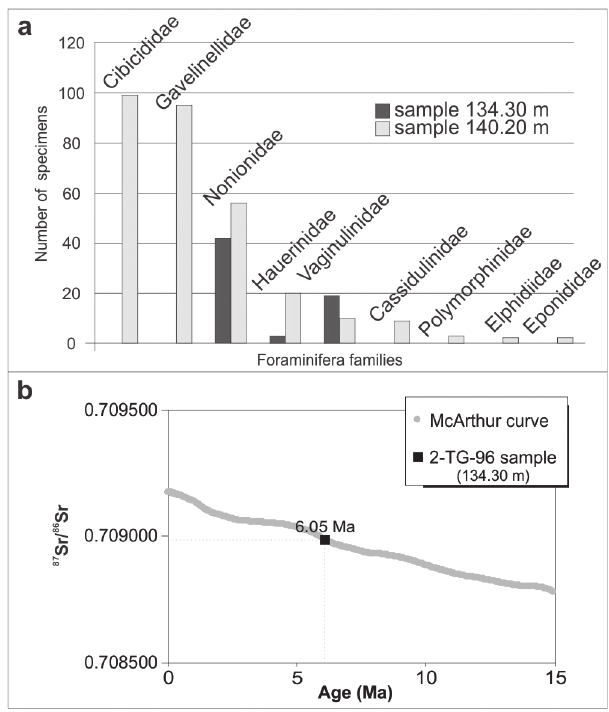
Fig. 6 - Number of specimens of benthic foraminifera per family in the samples 140.20 m and 134.30 m (a) and 87 Sr/ 86 Sr ratio and the obtained age for the analyzed sample (b)